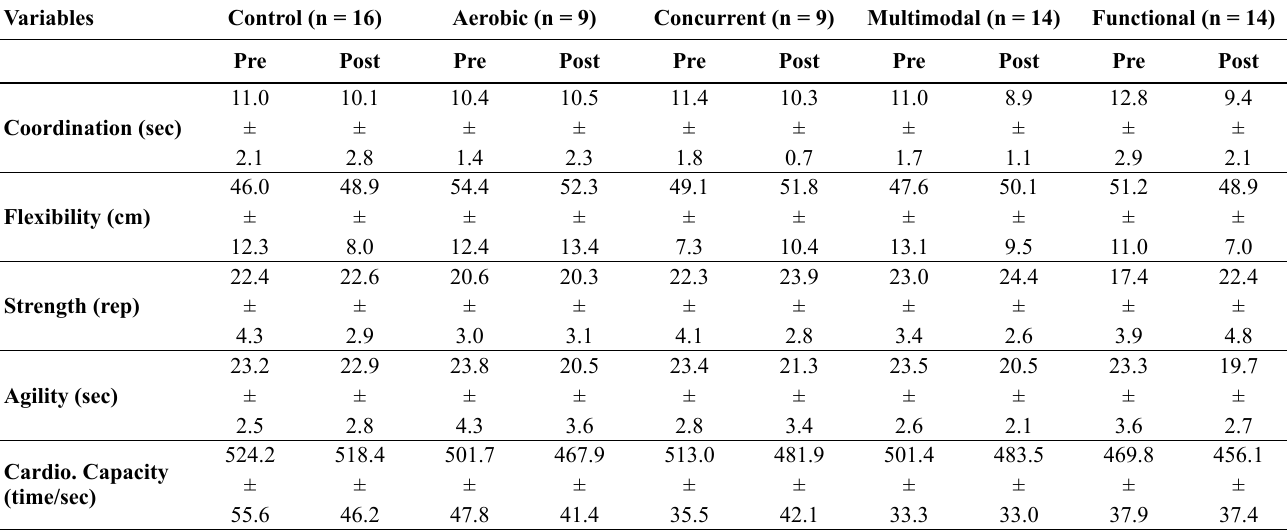
Table 2. Characteristics of the participants before and after the exercise program in different capacities.